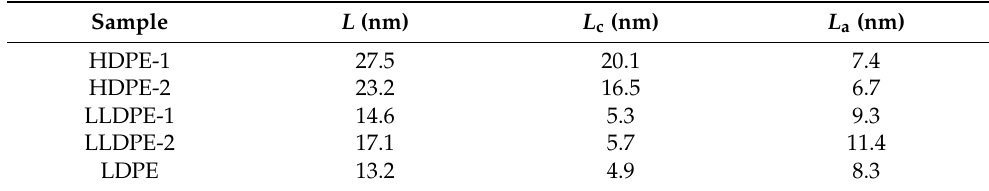
Table 3. Data of the long period ( L ), crystalline phase thickness ( L c ), and amorphous phase thickness ( L a ) obtained from the one-dimension correlation function.